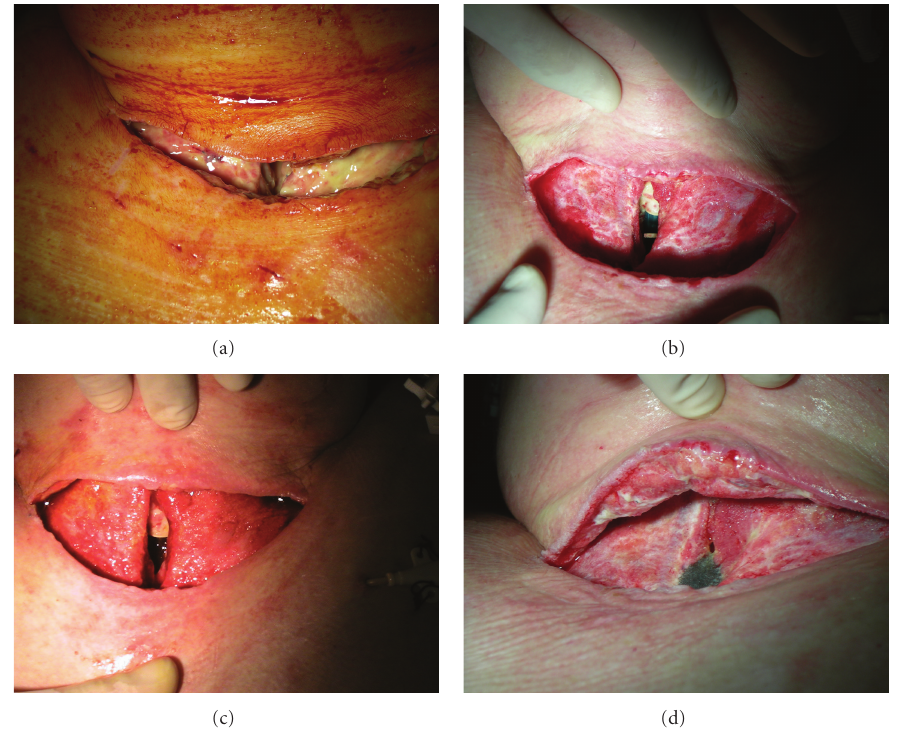
Figure 1: Time course of anterior tracheal necrosis under